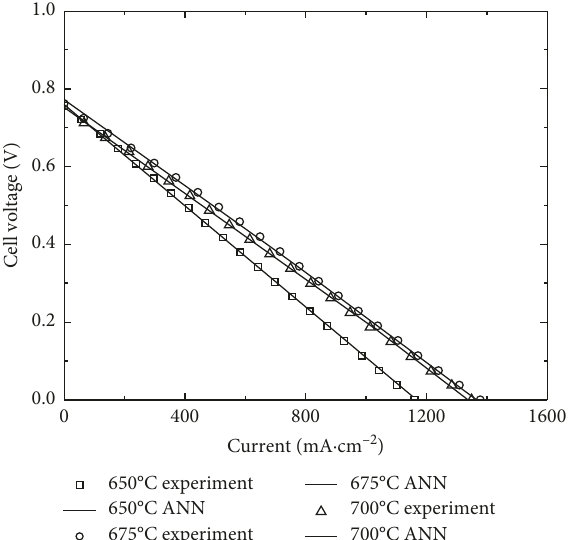
Figure 8: Comparison of I - V curves for the cathode sintered at 1050 ° C and operated at different temperatures by the ANN model and experimental data.